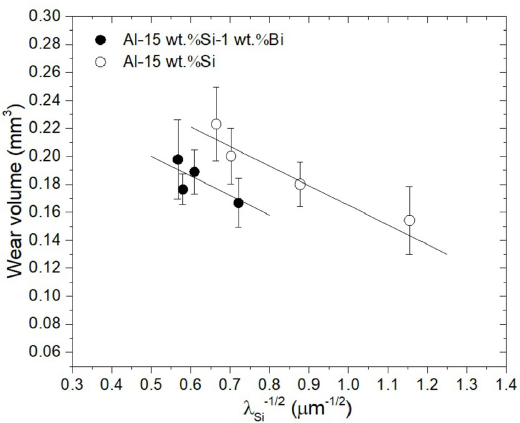
Figure 7. Experimental variation of wear volume with the Si spacing measured in the Al-15 wt.%Si and Al-15 wt.%Si-1 wt.%Bi alloys samples for a test time of 30 minutes (i.e., 598.2